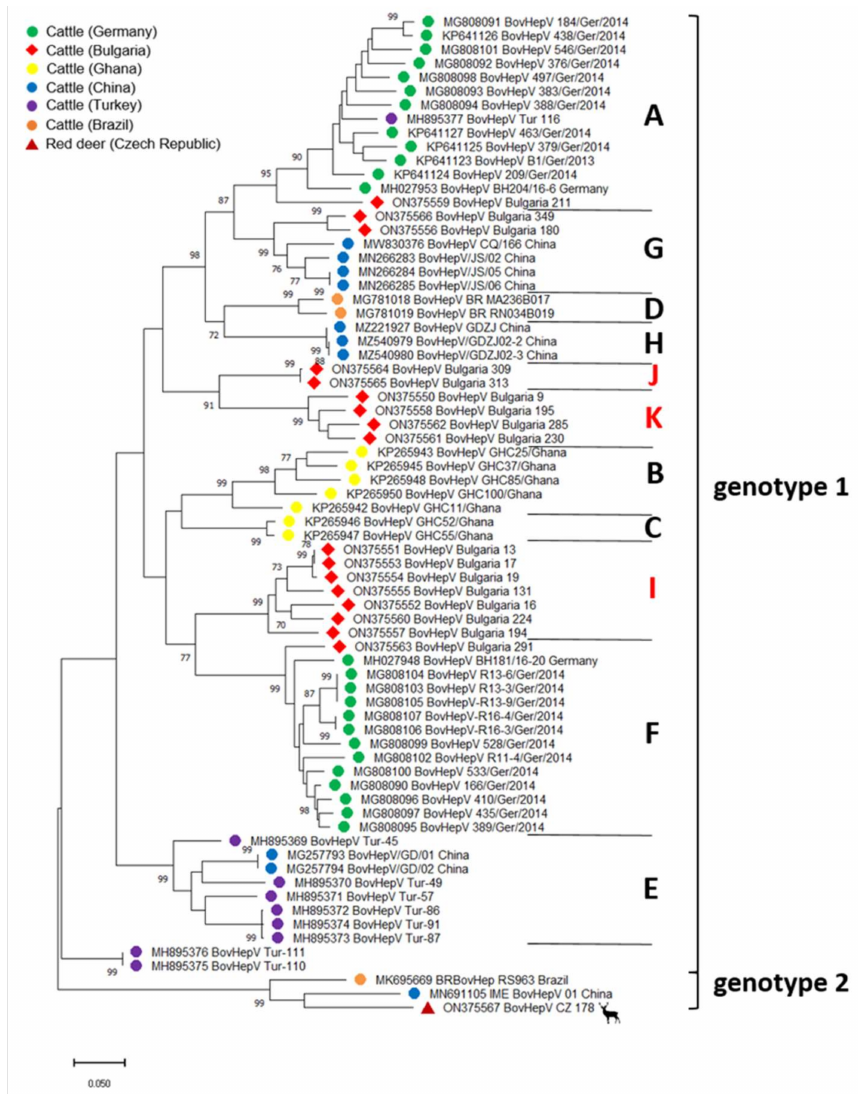
Figure 2. Maximum Likelihood phylogenetic tree based on partial NS3 coding sequences (835 nt) of hepaciviruses in ruminant species. Bootstrap values <70% are not shown. BovHepV subtypes (in capitals) and genotypes are indicated on the right. Color codes of BovHepV sequences specify the country of origin. The newly discovered Bulgarian sequences are marked with a red rhombus and the newly described subtypes I–K are depicted in red letters on the right side. The newly discovered red deer sequence is marked with a red triangle. Scale bar indicates nucleotide substitutions per